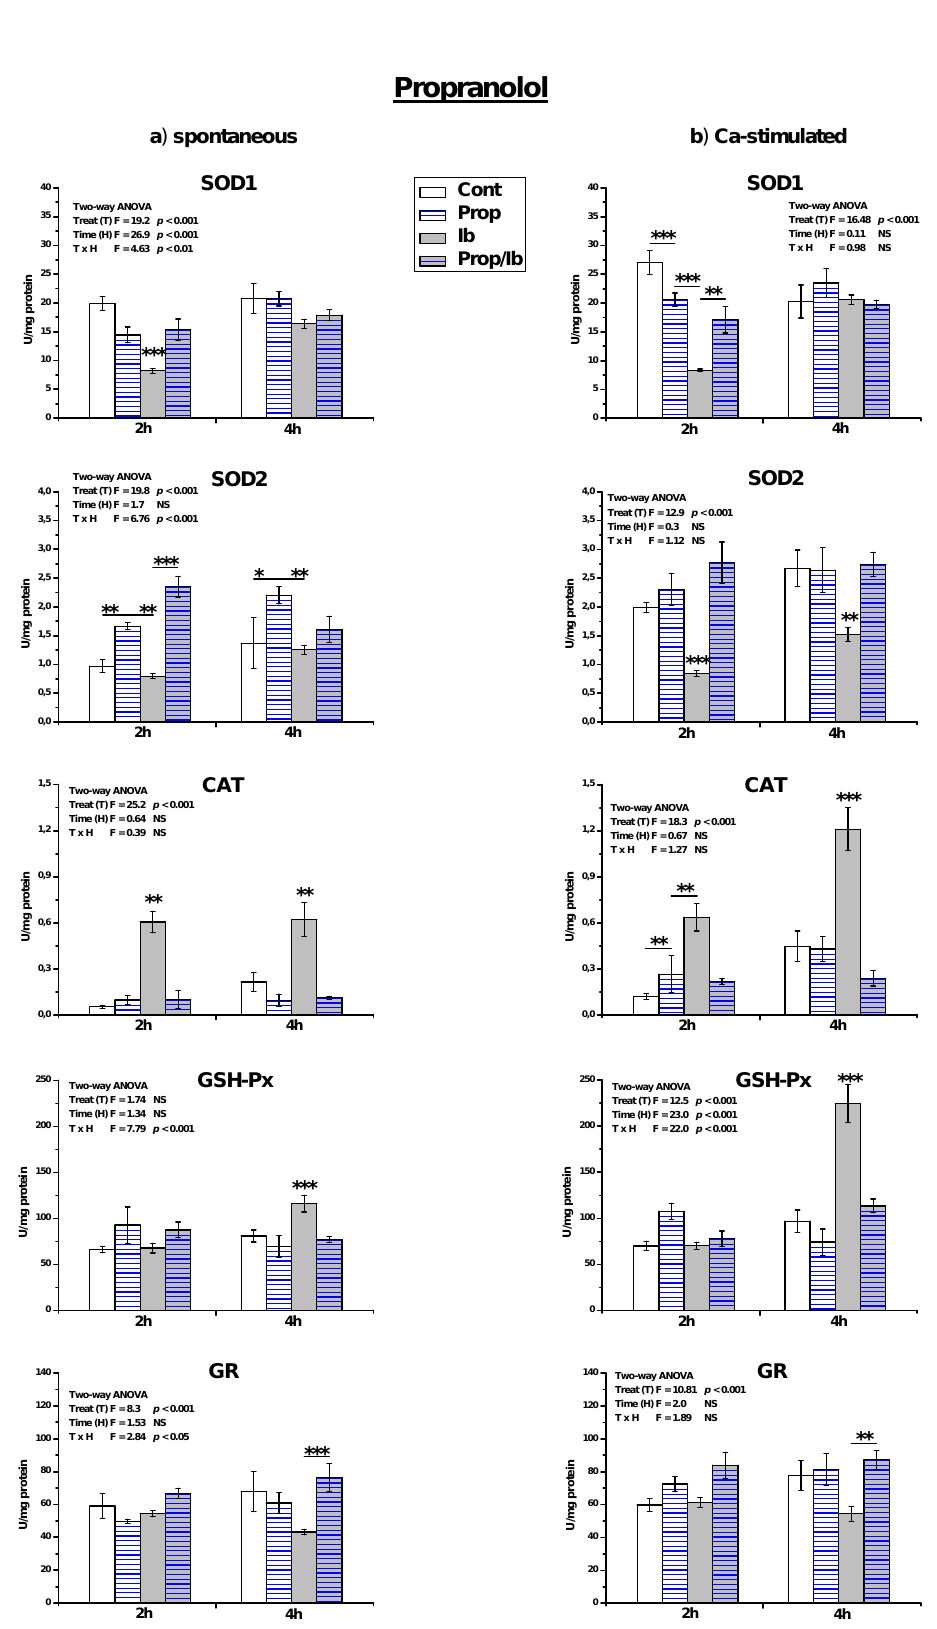
Figure 4. The activity of antioxidant enzymes in both spontaneous ( a ) and Ca 2+ -stimulated ( b ) active uteri treated with a single dose of ibogaine (28.8 µ mol/L) and pre-treated with propranolol. Data are expressed as the mean ± SEM ( n = 7). Statistical significance was tested by two-way ANOVA and post hoc compared by Tukey’s HSD test. * p < 0.05; ** p < 0.01; *** p <